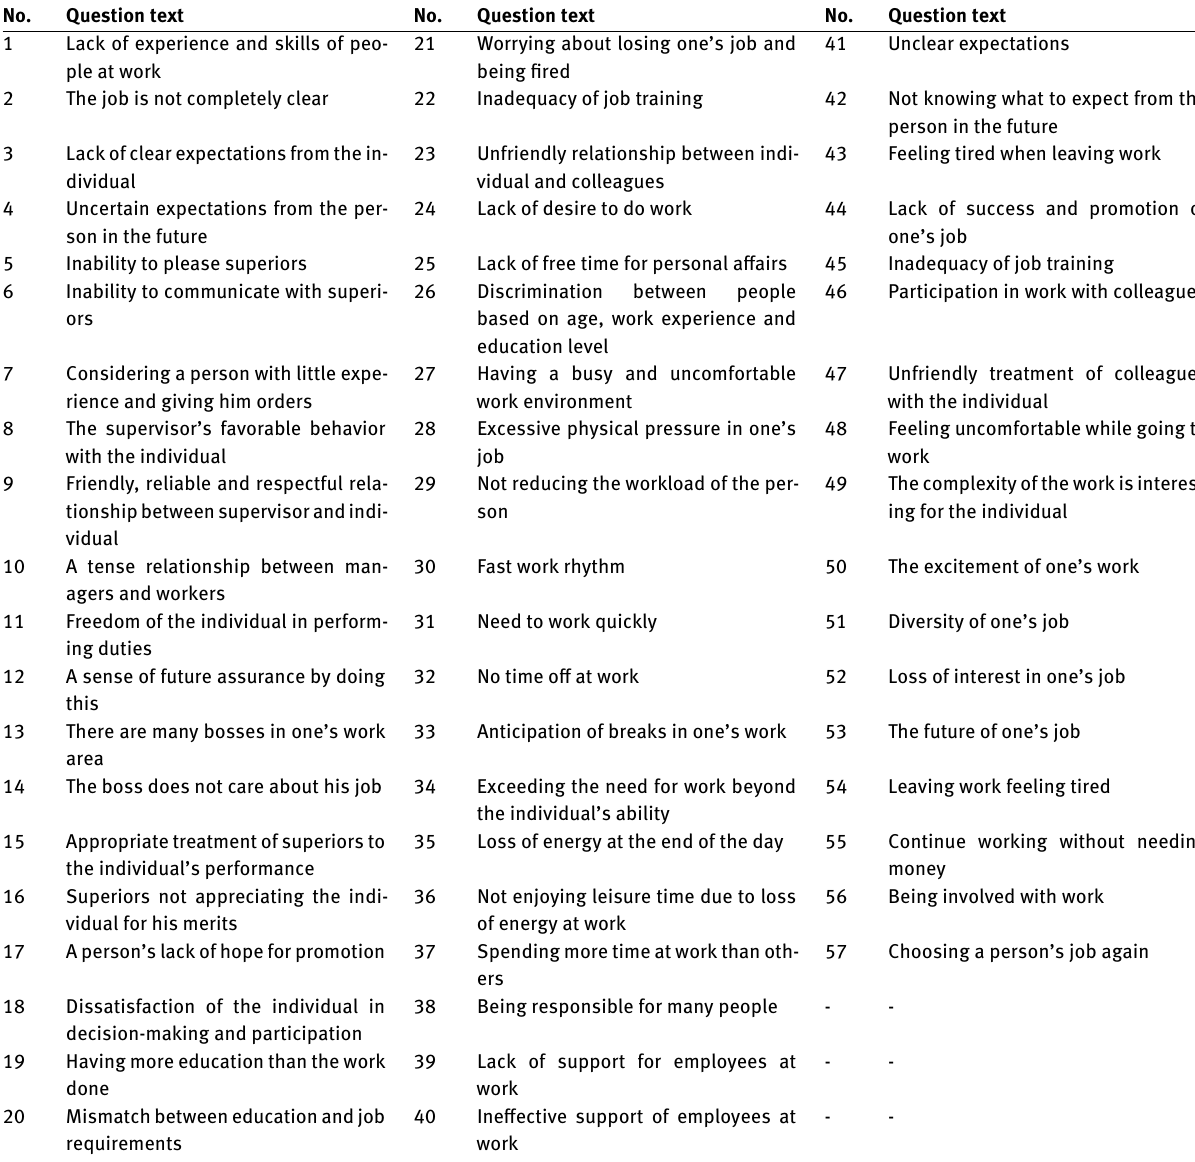
Table A1: The text of the Philip L. Rice